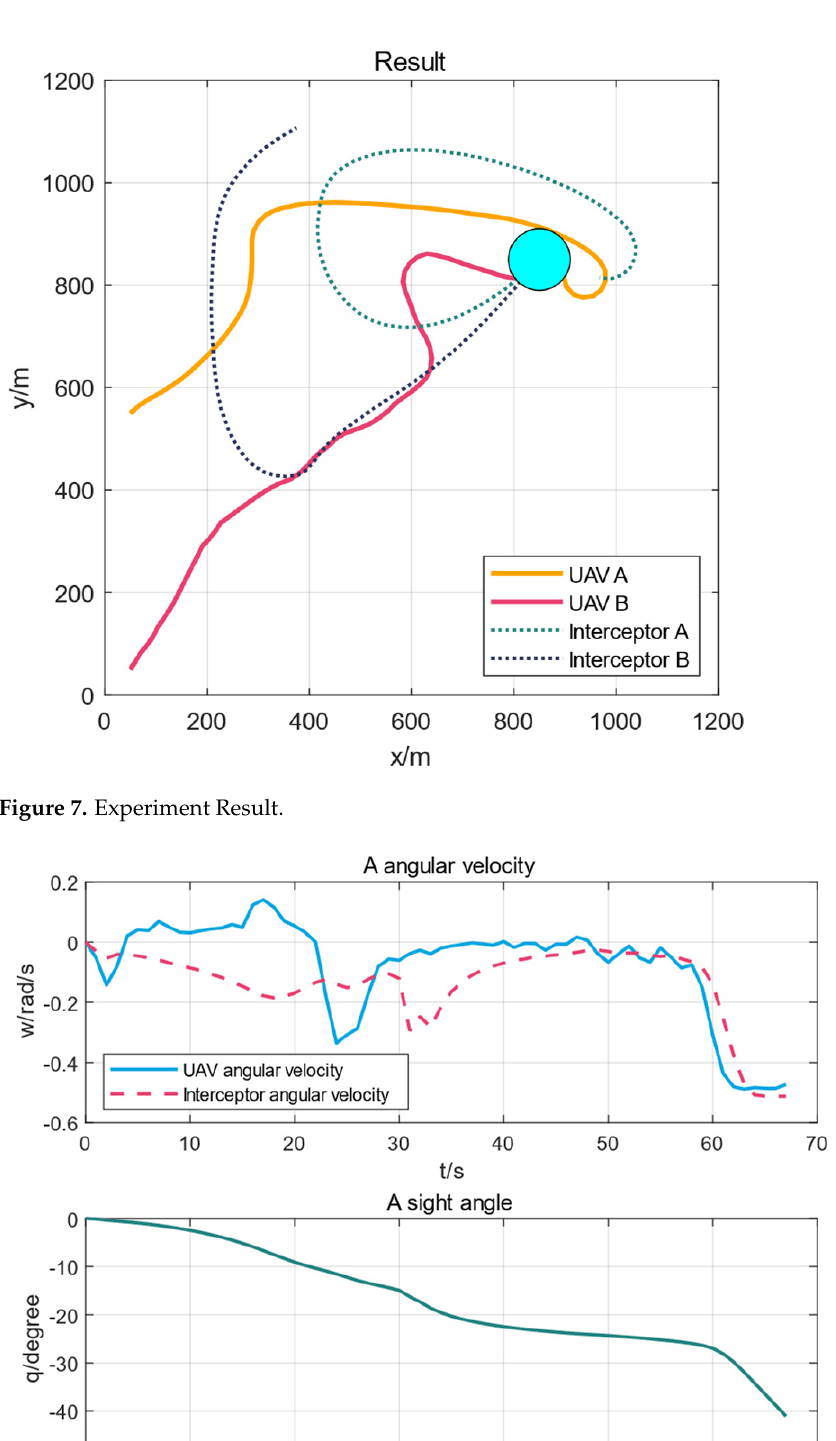
Figure 9. The parameter change curve of UAV B and Interceptor B during training. It can be seen from the figure that the UAVs carried out a wide-angle exercise, the interceptor’s line of sight to the UAVs continued to increase, and the interception failed. Figure 10 shows the distance curve between the two UAVs and the interceptor. The black line at the bottom of the figure represents the distance captured by the interceptor. Figure 10. The distance between the UAV and the interceptor.